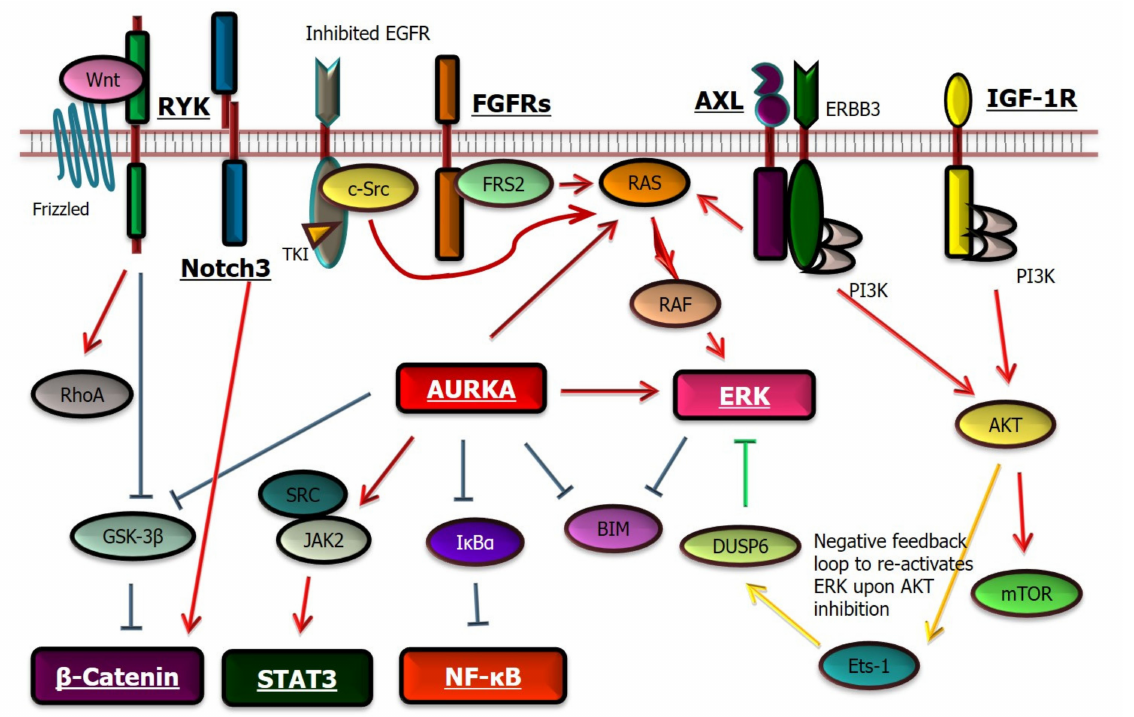
Figure 3. Molecules and associated signaling pathways that may mediate drug tolerance in EGFR -mutated lung cancer cells upon treatment with an EGFR TKI. Molecules known to cause drug tolerance are indicated with underlined bold letters. Molecules such as PI3K, AKT, mTOR, or c-Src may play important roles in drug tolerance [36,52], and other candidates not illustrated here include inhibited apoptosis, altered chromatin state, stabilized EGFR through a de-ubiquitinase, involvement of the tricarboxylic acid (TCA) cycle, induced ER stress, and upregulation of cholesterol